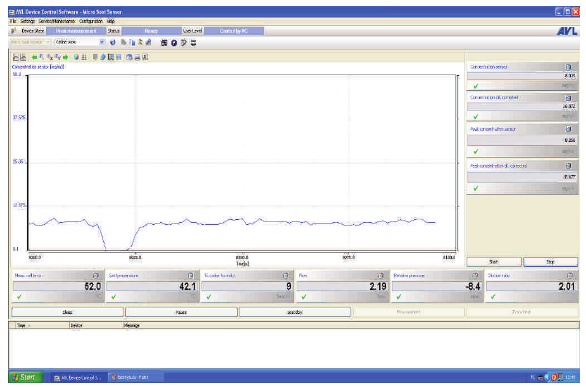
Fig. 6. A view of program window used to record soot concentration in exhaust gases